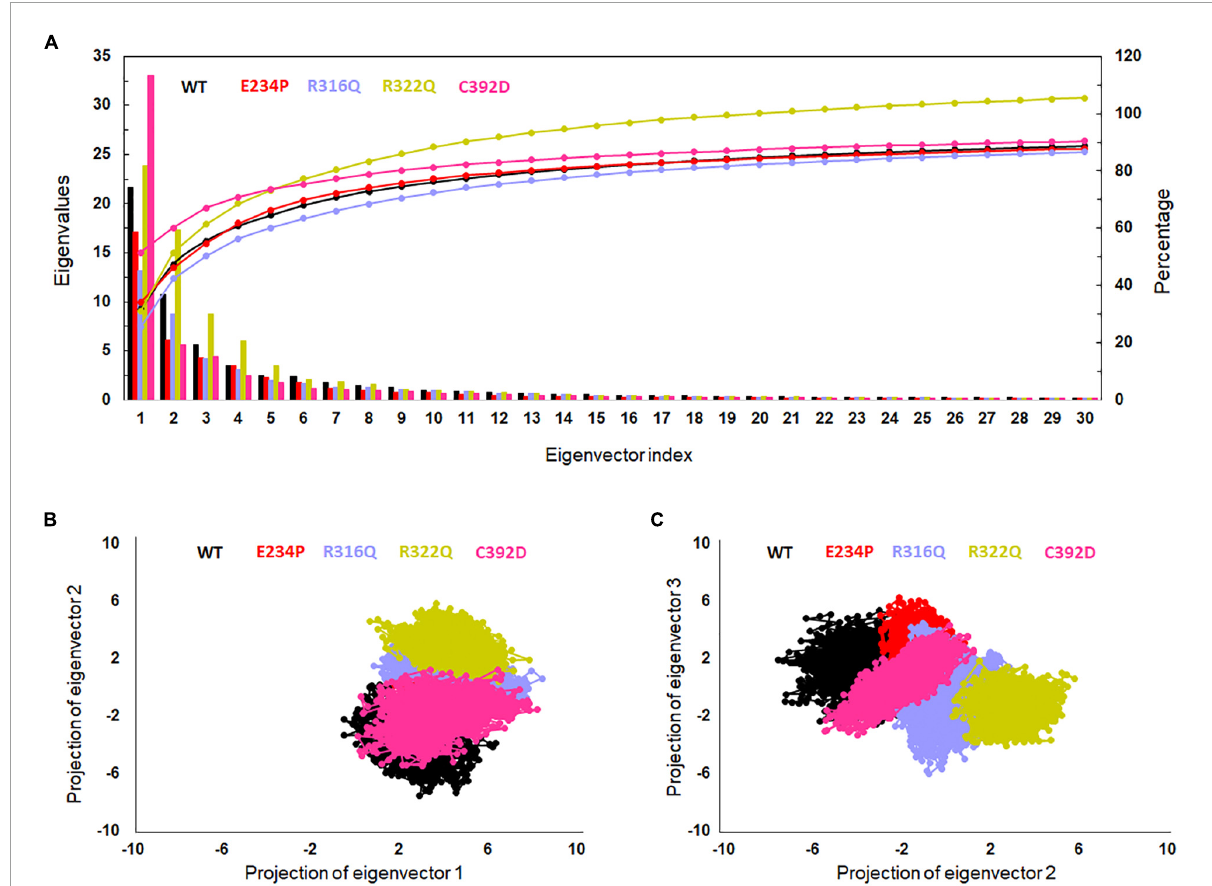
FIGURE4 Essential dynamics profile of WT and MT proteins. (A) Plot of first 30 eigenvectors with corresponding eigenvalues. (B) Projection of eigenvector1 versus eigenvector2 and (C) projection of eigenvector2 versus eigenvector3. WT, E234P, R316Q, R322Q, and C392D were labeled in black, red, blue, mustard, and magenta color,